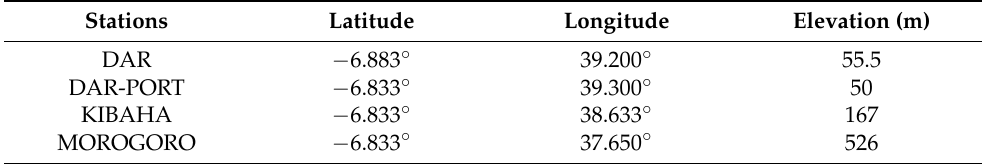
Figure 3. Topography in the analyzing domain and the location of meteorological observation stations used for LULC analysis. Table 2. Latitude, longitude, and elevation of the selected meteorological stations.